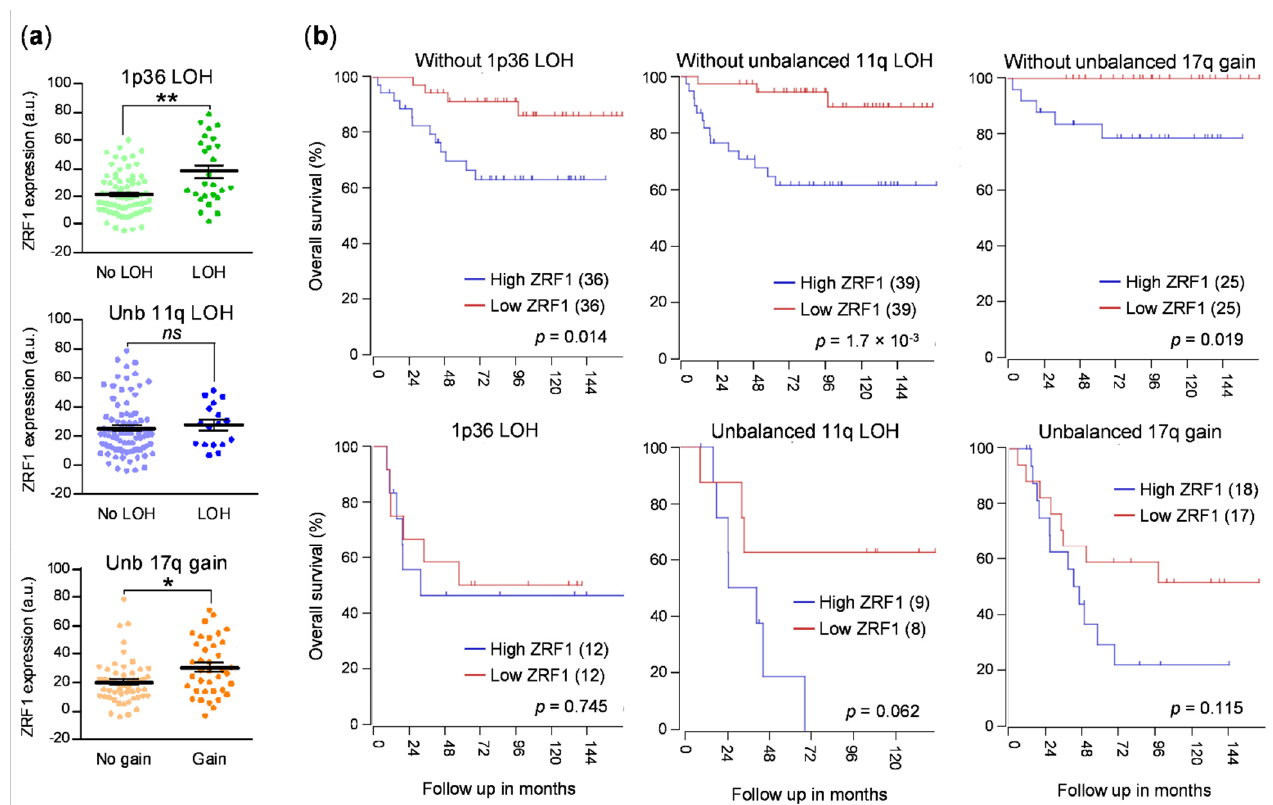
Figure 2. ZRF1 levels correlate with low survival in the absence of genomic alterations associated with poor prognosis. ( a ) ZRF1 mRNA levels in the presence or absence of the indicated segmental copy alterations (GSE3960, n = 101). ( b ) Kaplan–Meier survival plots comparing high and low ZRF1 samples from the GSE3960 dataset, in the absence or presence of the different segmental copy alterations. ns means non-significant; * means p < 0.05; ** means p < 0.01.